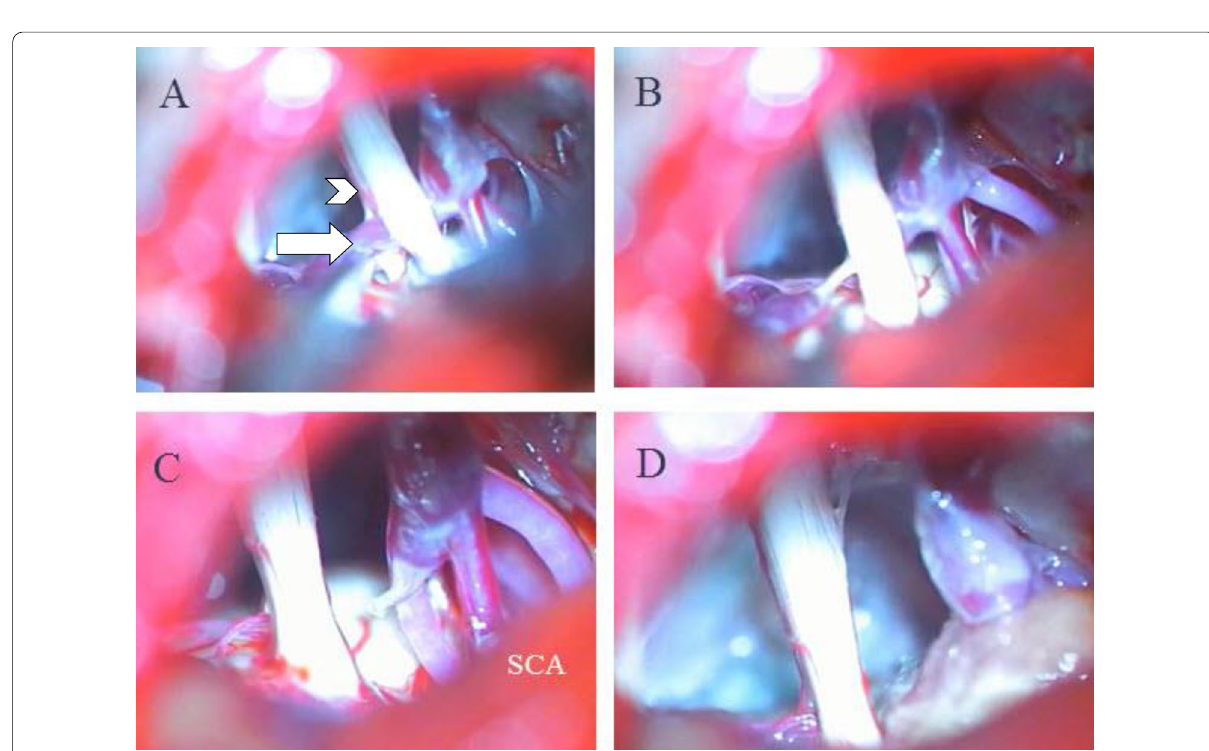
Fig. 3 Surgical approach of our case. A Intraoperative microscopical view of the neurovascular conflict via a retrosigmoid approach demonstrating a tributary of petrosal vein (long arrow) passing through the substance of trigeminal nerve itself (short arrow). B Coagulation of the offending vein prior to C dividing it proximal to the root entry zone of the trigeminal nerve with vivid view of the SCA (black arrow) beneath. D Transposing the stump by placing pieces of Gelfoam between the nerve and the vessel stump. SCA: superior cerebellar artery